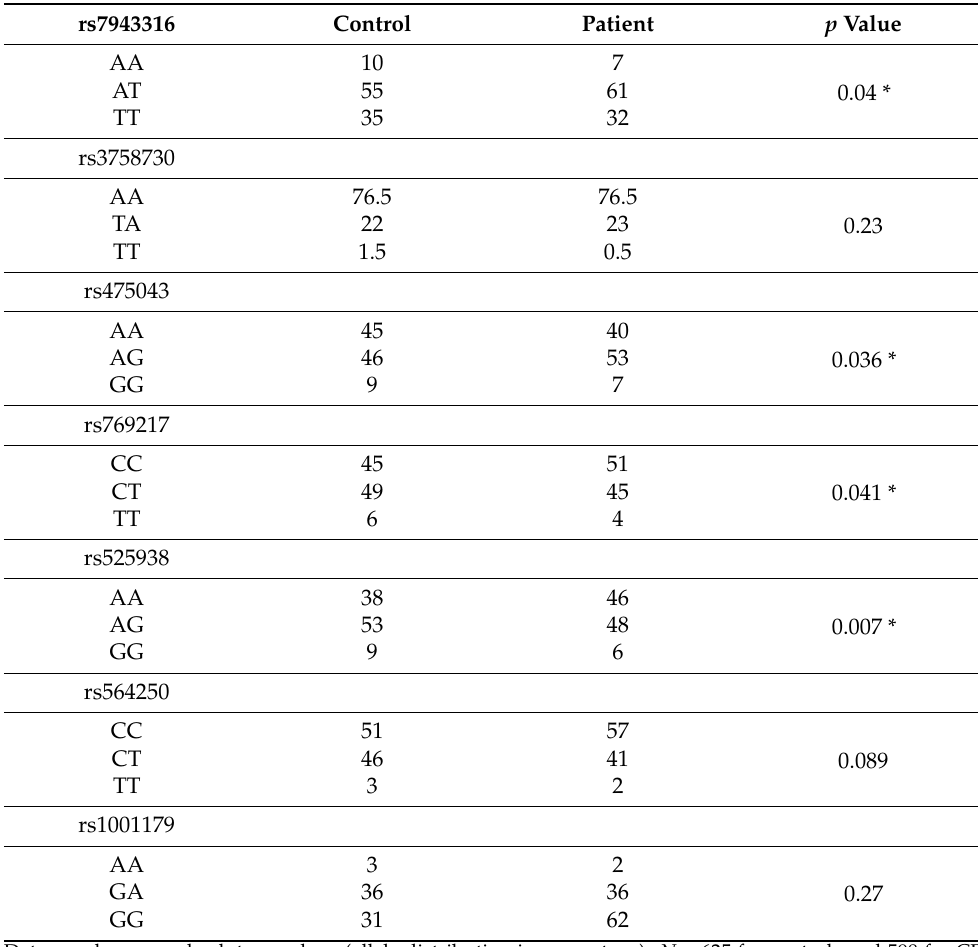
Table 3. Association of single nucleotide polymorphisms in the CAT -gene of peripheral blood samples of healthy subjects (controls) and Crohn’s disease